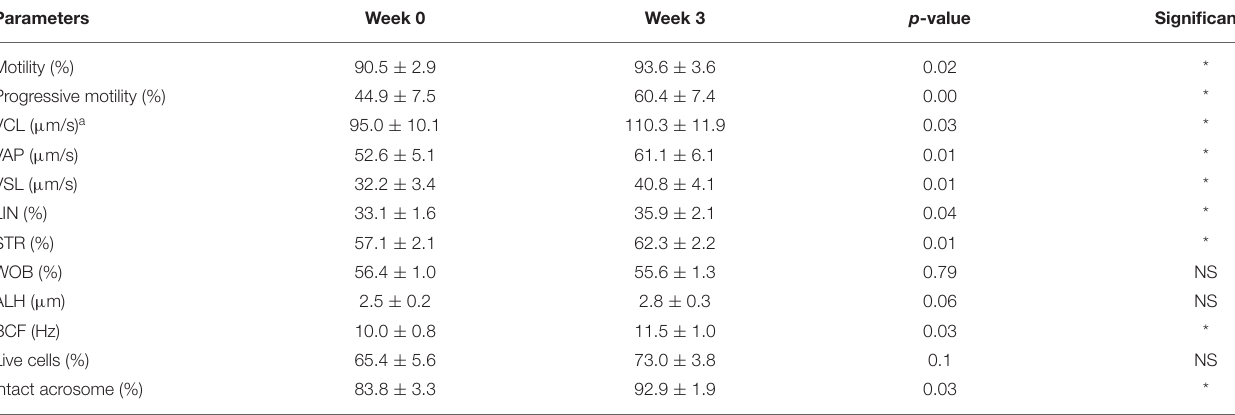
TABLE 1 | Sperm qualitative parameters in the first and last week of supplementation. Parameters